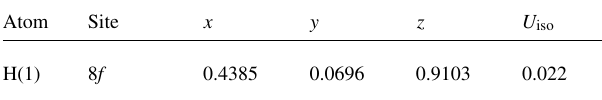
Table 2. Atomic coordinates and displacement parameters (in Å 2 )